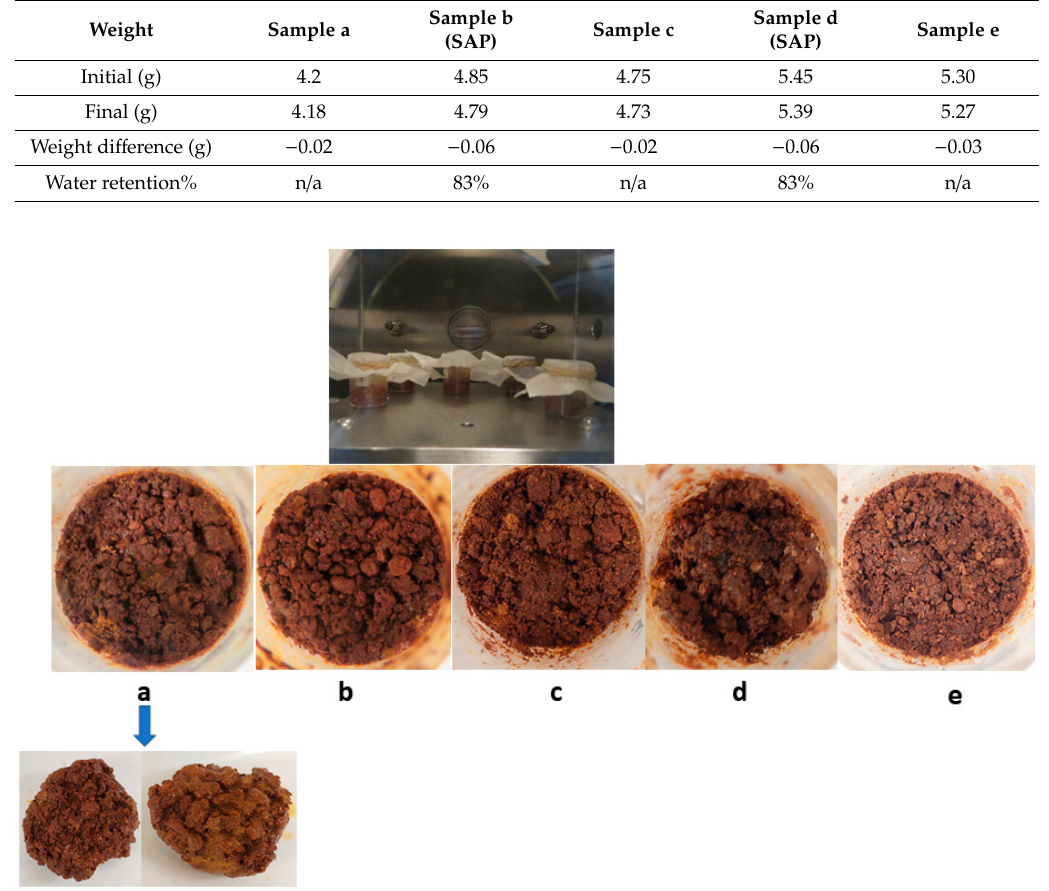
Figure 6. ( a ) 3 g soil, ( b ) 3 g soil + SAP, ( c ) 3.5 g soil, ( d ) 3.5 g soil + super absorbent polymer